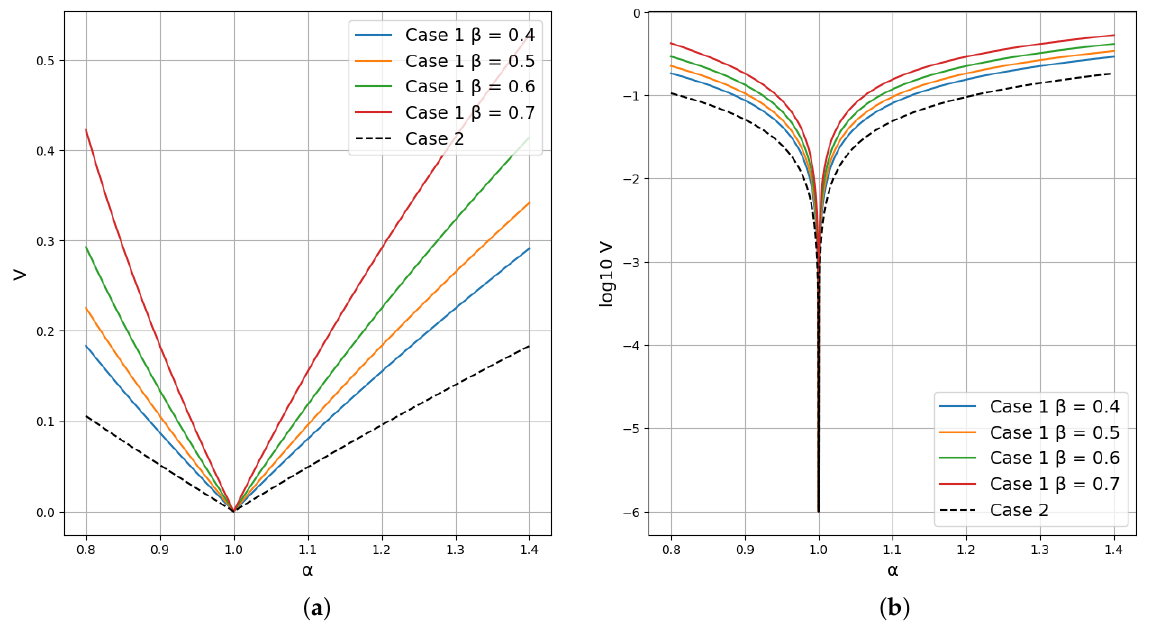
Figure 2. ( a ) The normalised value of information for two cases of uncertainty. ( b ) The logarithm of the normalised value of information for two cases of